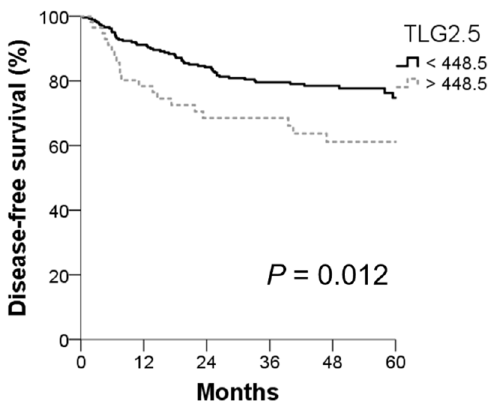
Figure 1. Disease-free survival according to total lesion glycolysis